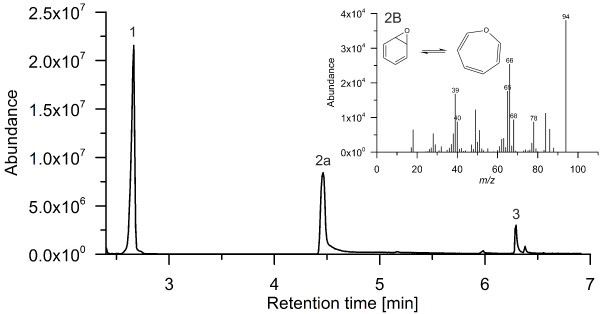
Gas chromatogram of a benzene sample treated with AaeAPO: benzene (1), benzene oxide (2a), and phenol (3). The inset (2b) shows the 70 eV mass spectrum of benzene oxide obtained by LC-MS/MS.